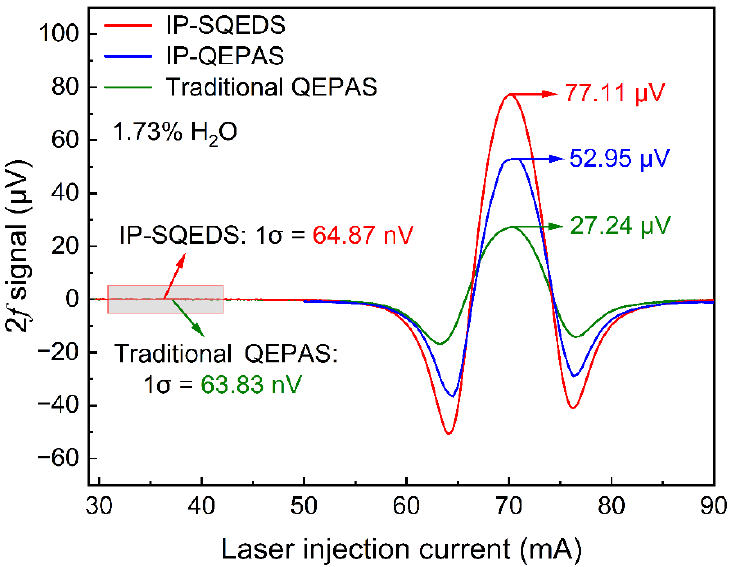
Figure 7. 2 f signals of IP-SQEDS, IP-QEPAS and traditional